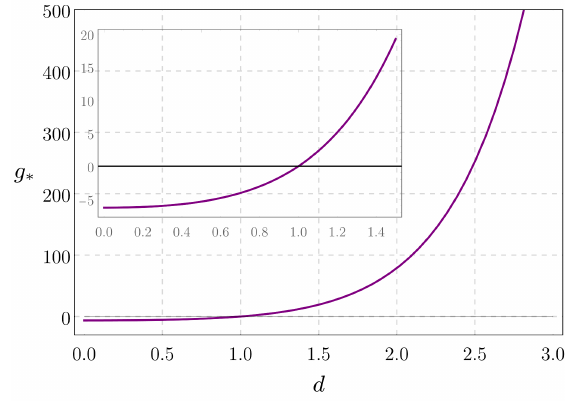
Figure 1 . Position of the NGFP for g k as function of the spatial dimension d .